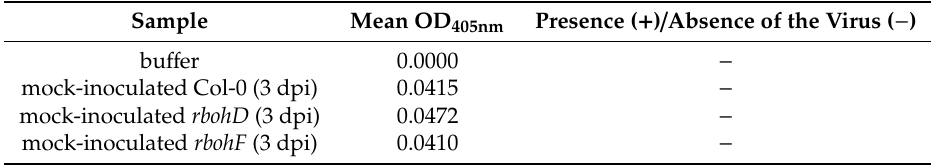
Table 1. Turnip mosaic virus (TuMV) detection assessment using double antibody sandwich enzyme-linked immunosorbent assay (DAS-ELISA) on Arabidopsis thaliana wild type and mutant leaves at 3 and 7 dpi. Values presented are mean optical density (OD 405nm ) values. Absence of virus is marked by ( − ). Presence of TuMV ( + ) is confirmed in samples with mean OD 405nm above estimated cut-o ff point: